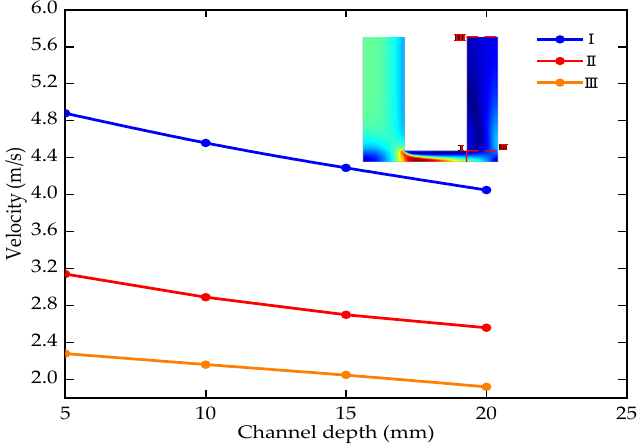
Figure 11. Electrolyte flow velocity with different machining depths.